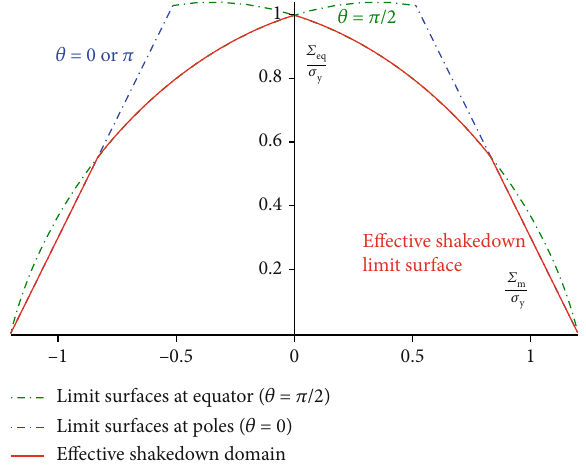
Figure 5: Limit surfaces de fi ned by the proposed macroscopic shakedown criterion of porous geomaterials taking f = 0 : 1 , ν = 0 : 2 , and ϕ = 30